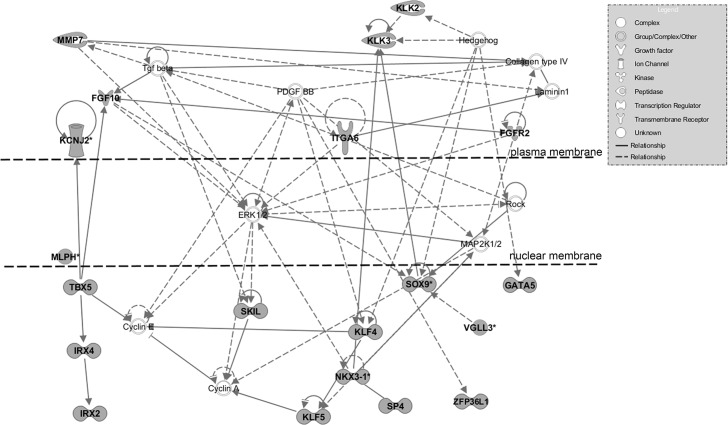
Gene-gene interactions among genes flanking prostate cancer risk alleles.A total of 97 unique genes contained or flanking the 86 prostate cancer risk loci. Gene-gene interactions were identified using the Ingenuity Pathway Analysis software. The most significant functional network demonstrating connectivity between genes was identified as having a potential function in Organismal Development, Embryonic Development, and Organ Development. The representative gene products are listed and putative functions listed in the legend. Gene products shaded in gray represent genes originating from the gene list.